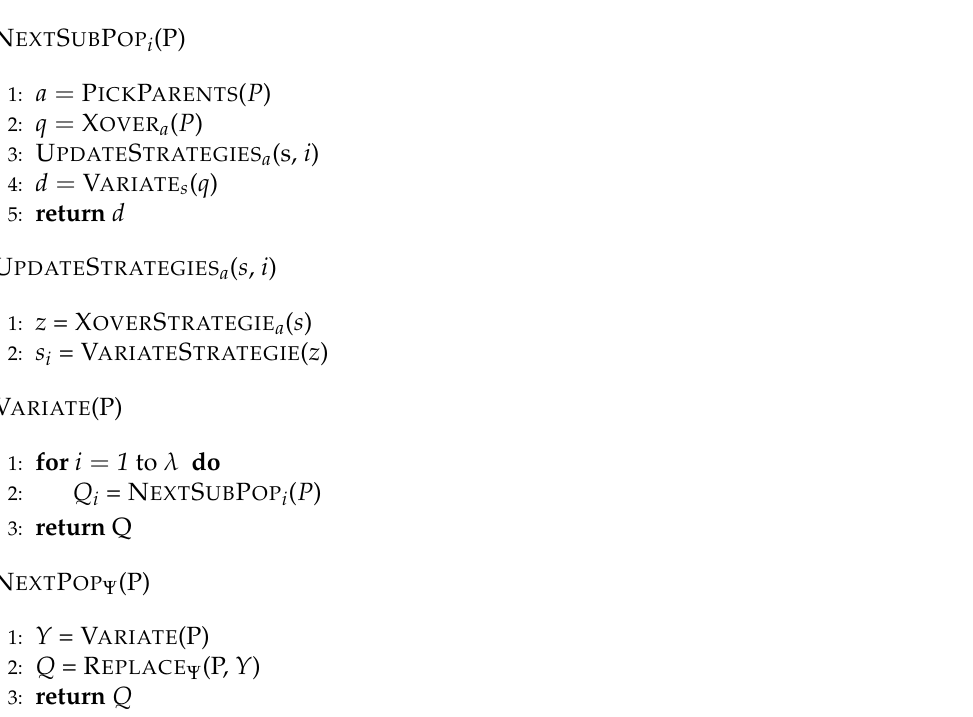
Algorithm 12 Evolutionary strategies algorithm-NextPop method described in terms of VR